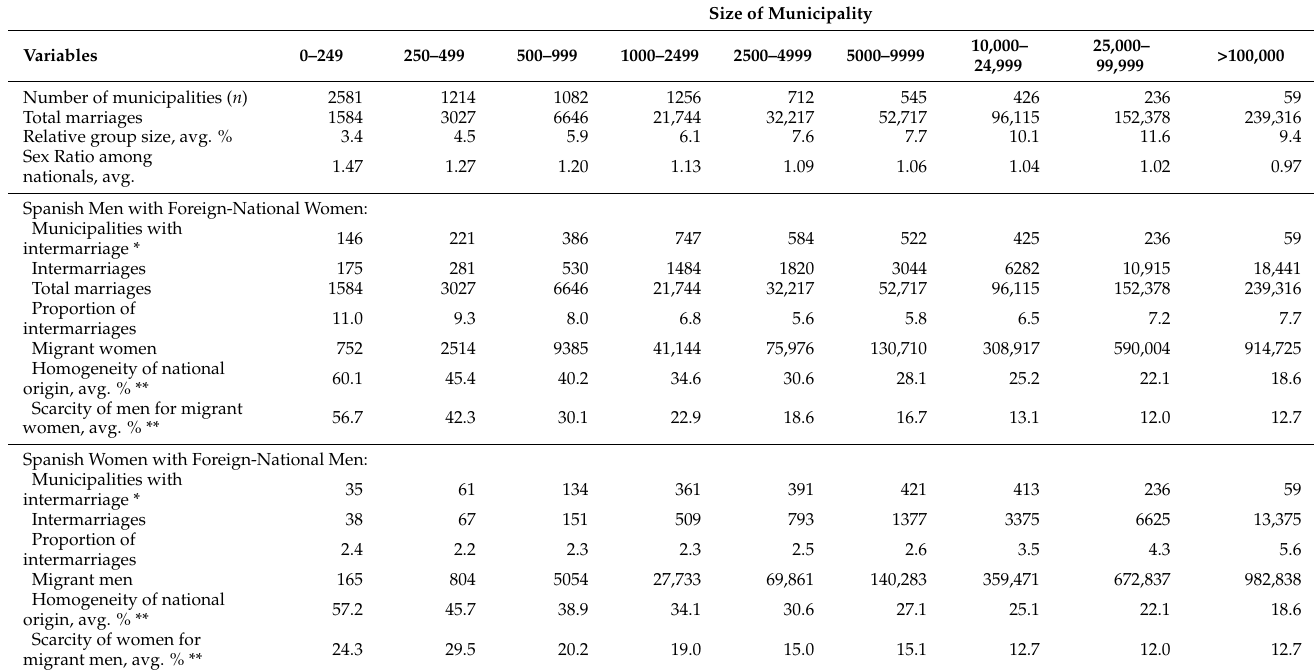
Table 2. Descriptive statistics for the variables utilized in the models. Size of